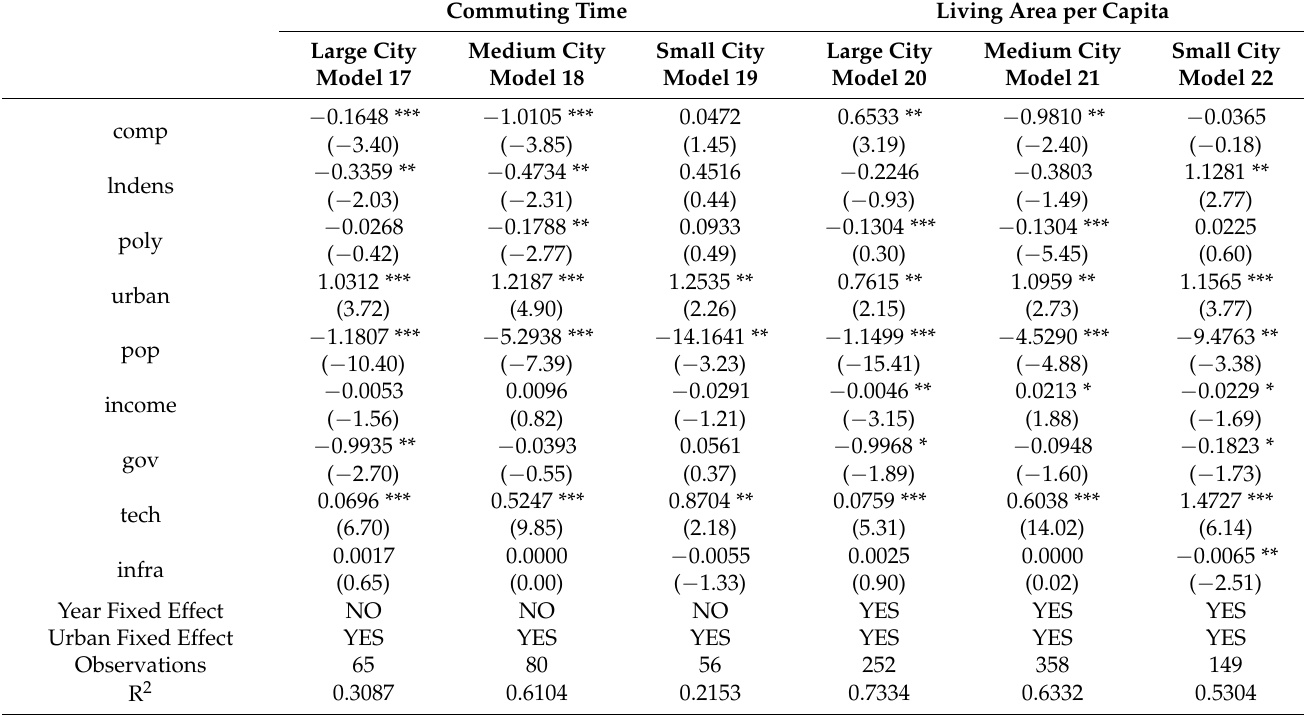
Table 6. Mechanism